Question: Is the quantity shown trending increasing or decreasing?
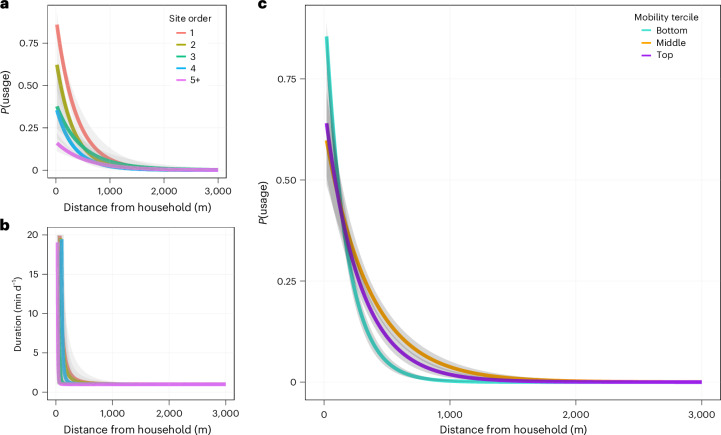
Answer: increasing